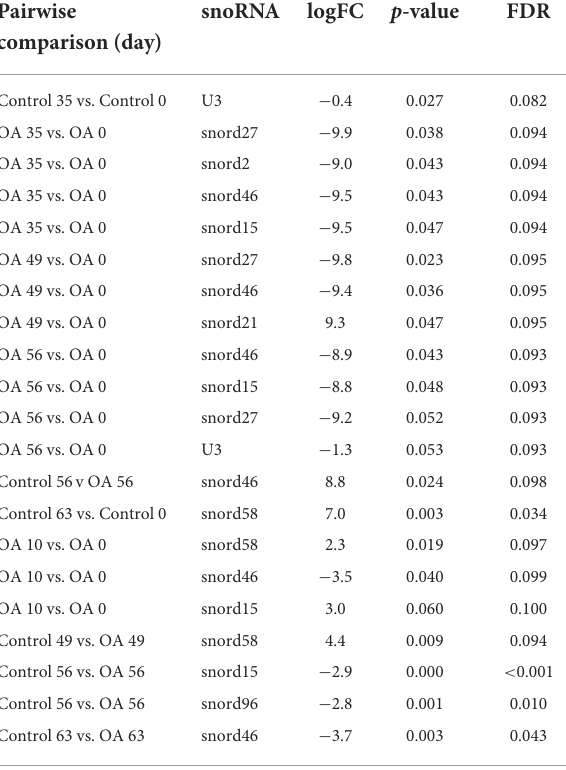
TABLE 3B Differentially expressed snoRNAs following pairwise analysis in synovial fluid-derived EVs.